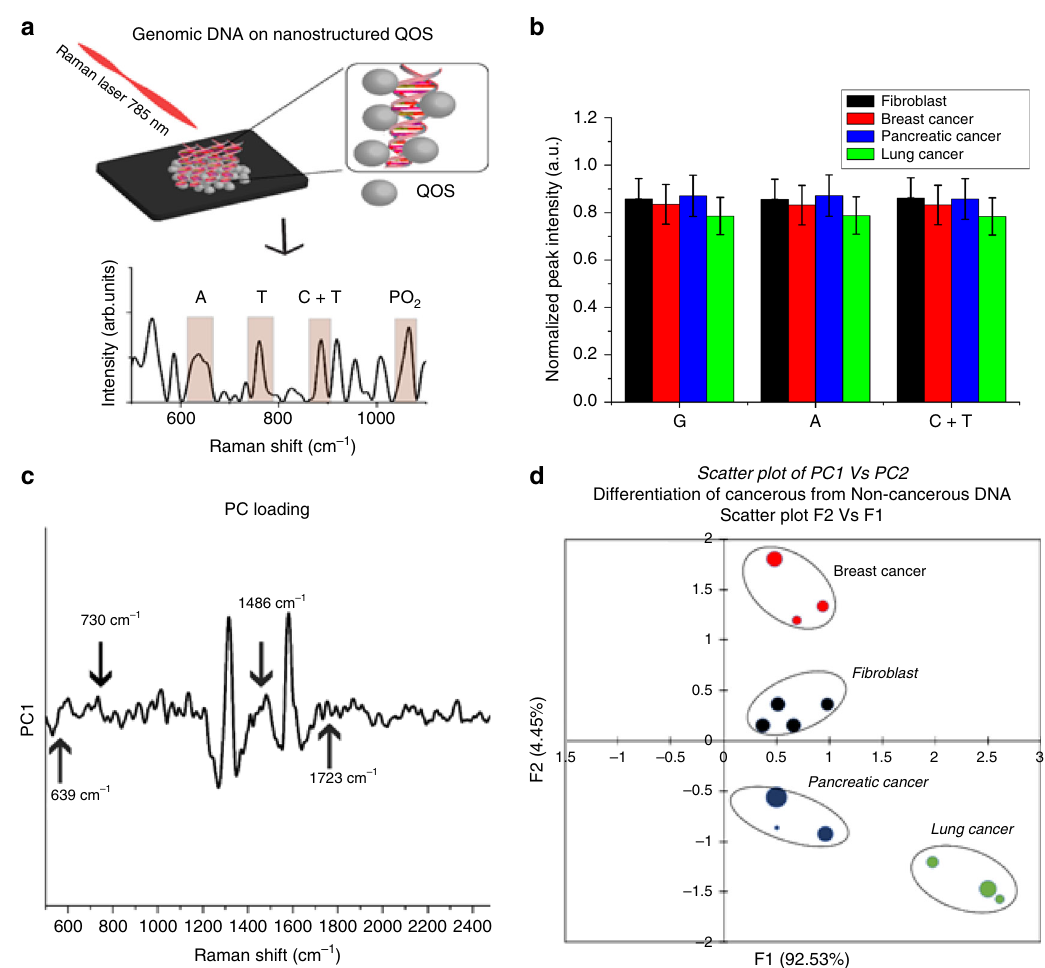
Fig. 5 Base composition analyses of genomic DNA. a Schematic representation of base composition analyses using SERS. b Normalized SERS peak intensity for various nucleic acid bases in genomic DNA of fi broblast, Breast Cancer, Pancreatic Cancer and Lung Cancer cells, c PC loading to determine the differences in the genomic DNA of the cellular models aiding in cancer detection d PCA analysis of genomic DNA derived from fi broblast, breast cancer, pancreatic cancer, and lung cancer